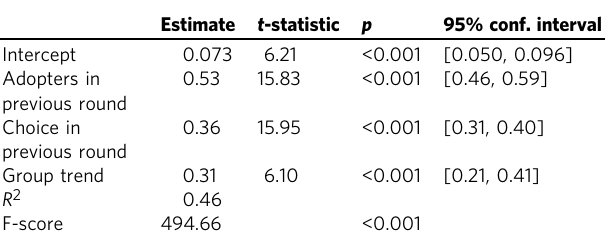
Table 1 Regression table displaying the effects of the three predictors — (fraction of) adopters in previous round, choice in previous round, and group trend — on the dependent variable choice in current